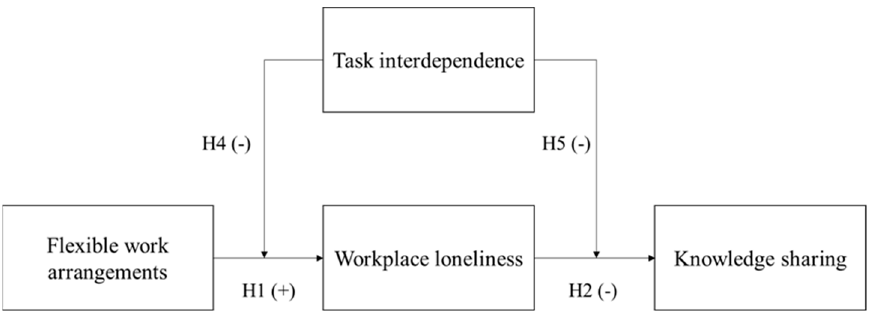
Figure 1. Theoretical